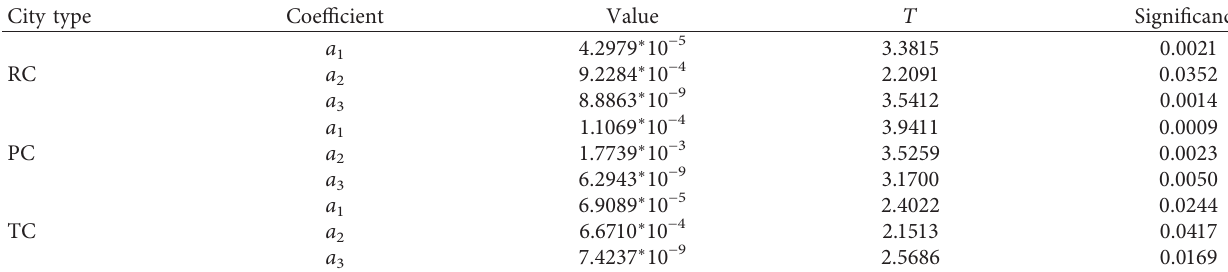
Table 6: Regression coefficient